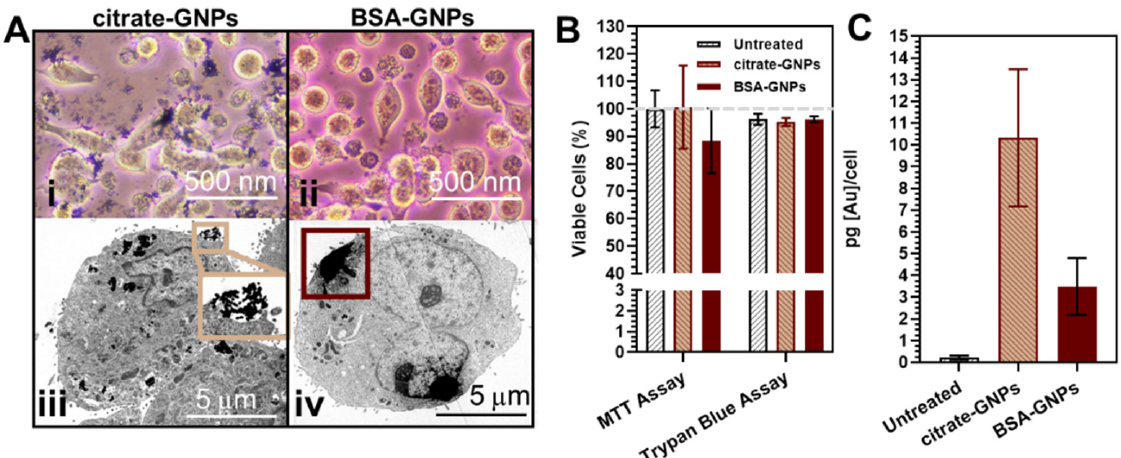
Figure 4. Evaluation of particle uptake and viability with LLC-Luc cells. ( A ) Optical microscopy (i,ii) and STEM (iii,iv) images of cells treated and incubated for 24 h. ( B ) 3-(4,5-dimethylthiazol-2-yl)-2,5-diphenyltetrazolium bromide (MTT) and Trypan Blue assays for cells treated and incubated for 24 h. No significant differences between groups. ( C ) Quantification of GNPs internalized in LLC-Luc by ICP-OES after 24 h. In ( B ) and ( C ) cells were treated and incubated in triplicate wells and data are plotted as the mean with s.e.m. Dashed line represents 100% cell viability.